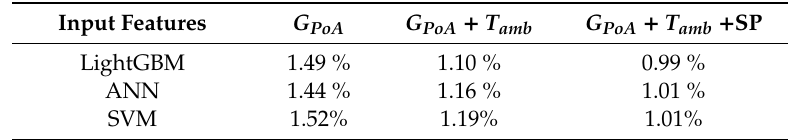
Table 4. nRMSE of each machine learning approach using di ff erent input features for the high accuracy